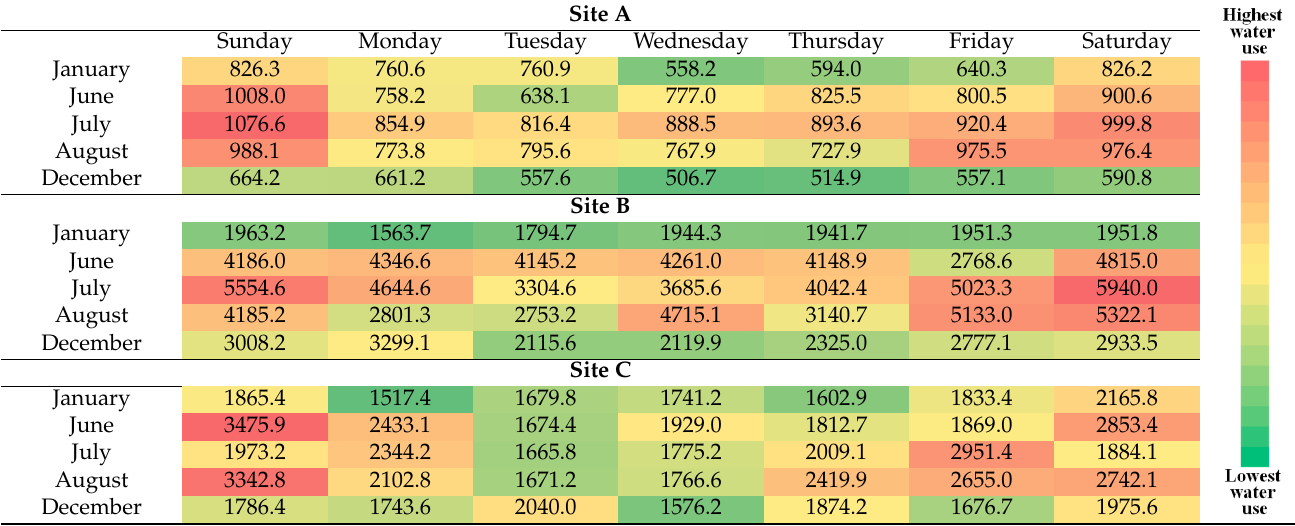
Table 3. Water use (gallons/day) for the three sites for the months of June–August, January and December for the period of 2015–2020 1